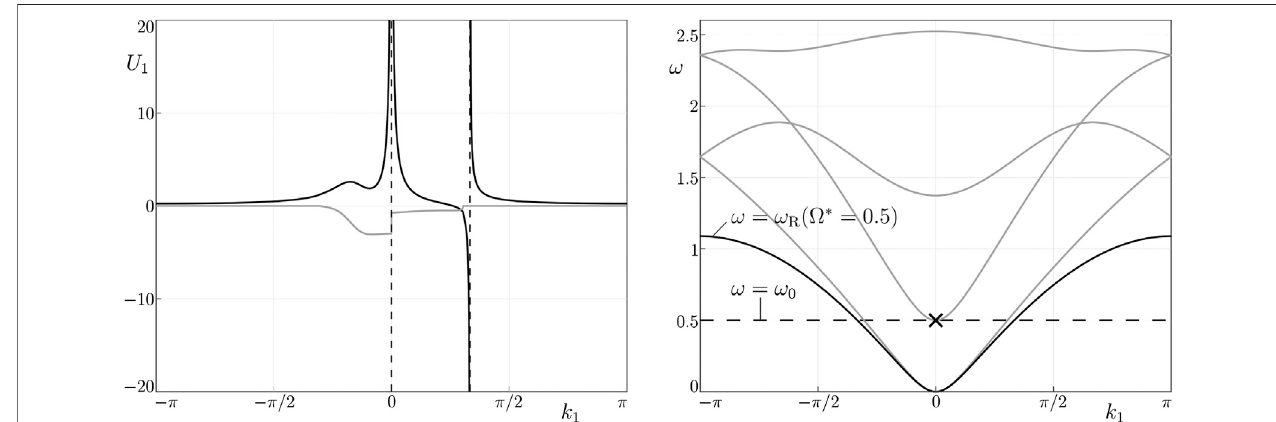
FIGURE 4 | (A) The fi rst component of the steady-state solution for the case of horizontal forcing on the boundary, with unit amplitude, when ω 0 (cid:1) Ω * . The black (gray)curverepresentsthereal(imaginary)partofthiscomponent. (B) Thedispersiondiagramfor ω 0 (cid:1) Ω * .ThedispersioncurveforRayleighwavesisrepresentedbythe black curve, based on Eq. 24 . The horizontal black dashed line represents ω 0 (cid:1) 0 . 5, which intersects the gray curves corresponding to , ω ) (cid:1) ( 0 , Ω * ) , indicated by the cross, corresponds to a resonance mode of the system. The computations in (A) and (B) have been performed for Ω * (cid:1) 0 . ( k 1 0